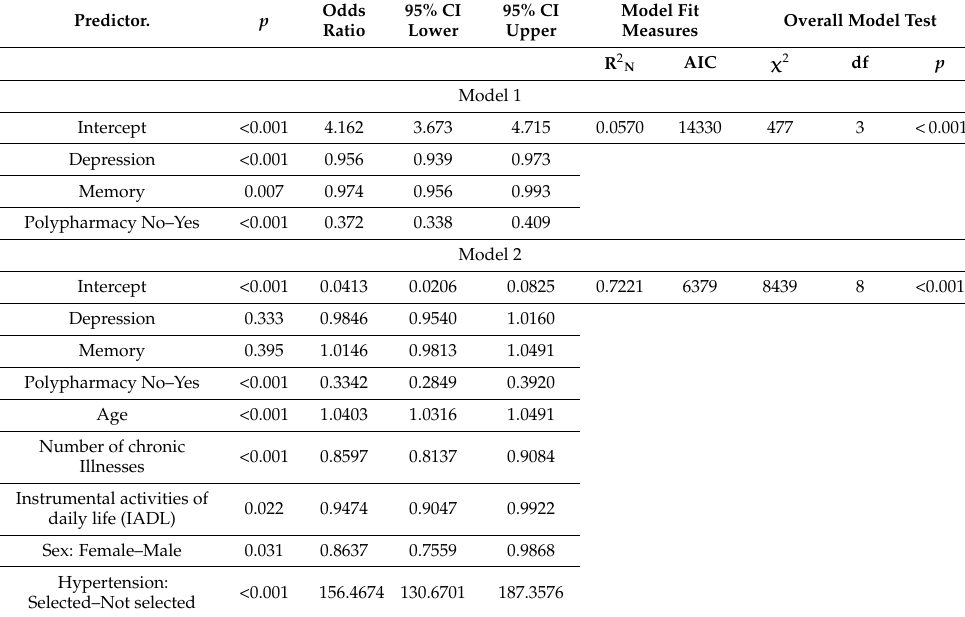
Table 3. Exemplary binomial logistic regression: drugs for hypertension. Predictor. p Odds Ratio 95% CI Lower 95% CI